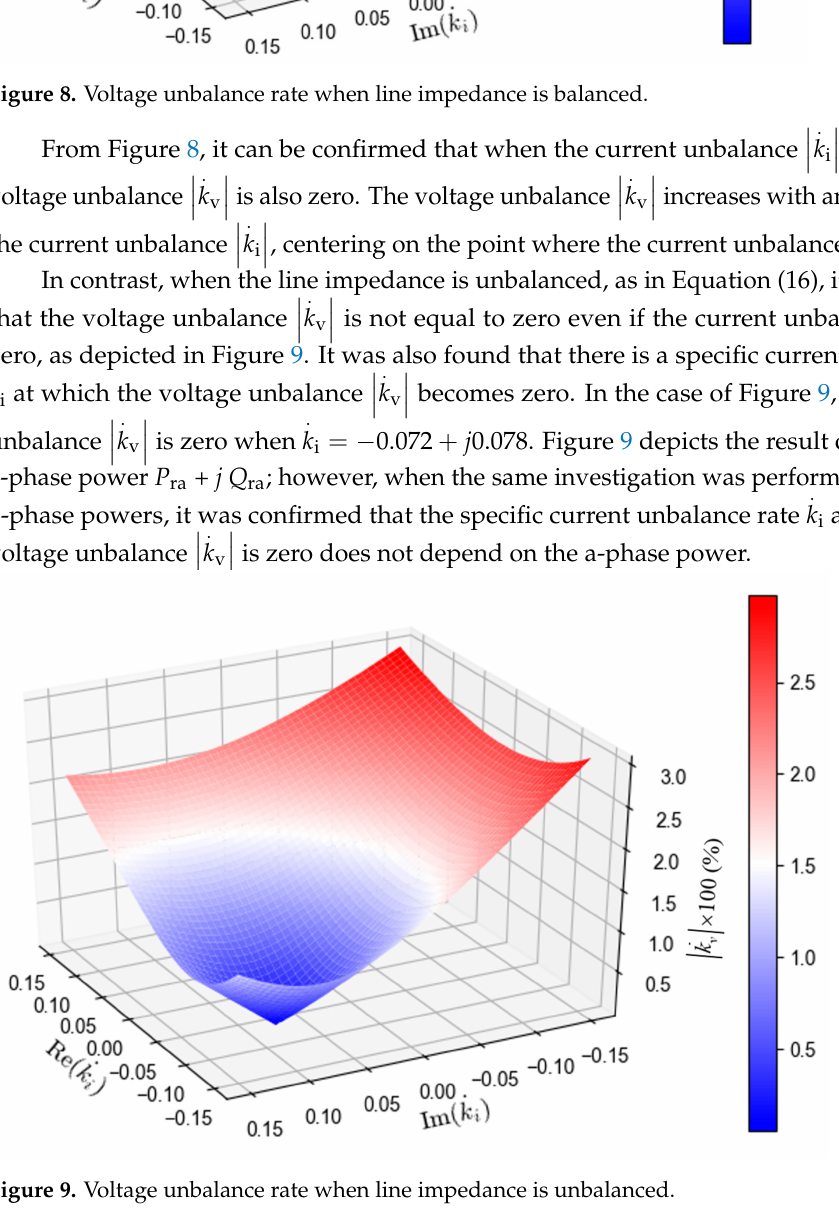
(cid:12) (cid:12) . (cid:12) (cid:12) k i (cid:12) (cid:12) is zero, the